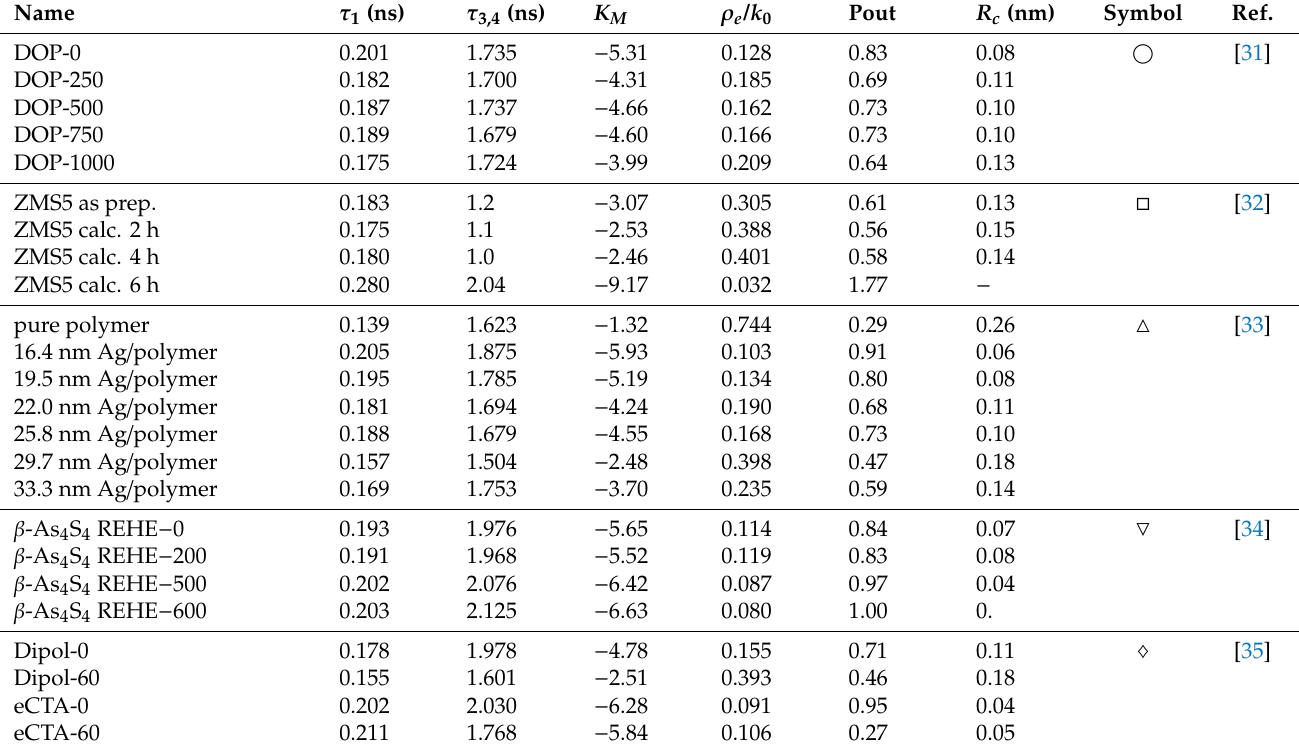
Table 2. Experimental PALS data for some solid materials organized in series having undergone di ff erent treatments (see text). Fourth and fifth columns report calculated K M and ρ e / k 0 . Sixth and seventh columns are discussed in next section. These series of materials are represented in Figure 3, with the symbols listed in eighth column of the